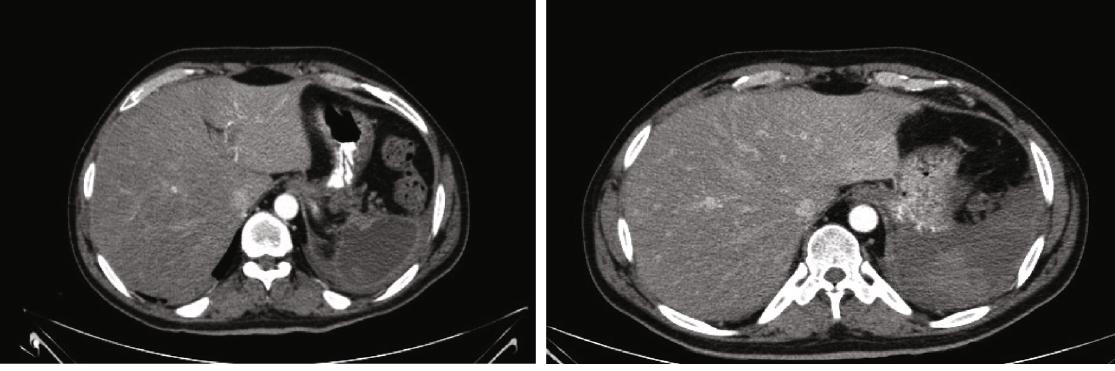
Figure 4: Abdominal CT shows a large collection of liquid on the left subdiaphragmatic space that contains solid material and is